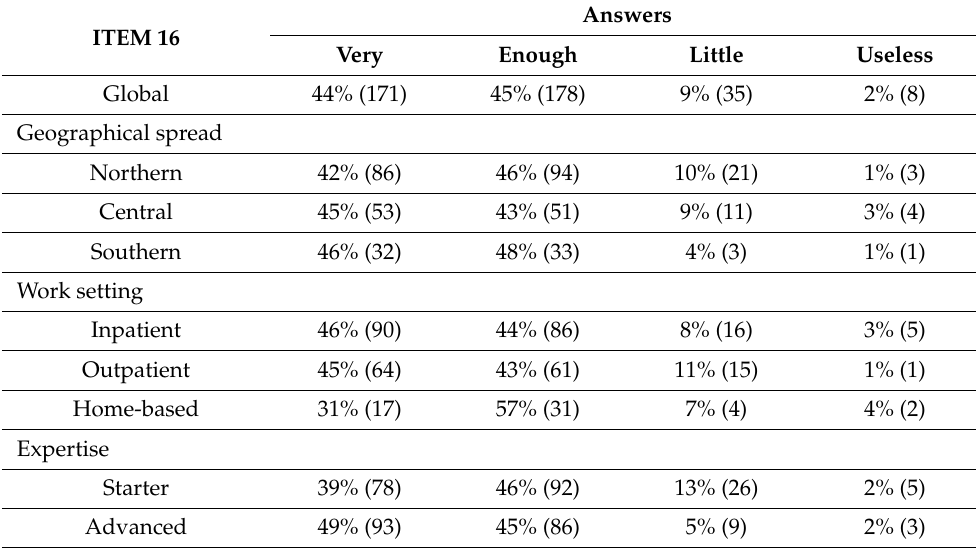
Table 7. Answers referred to item 16: How much do you think that an intensive